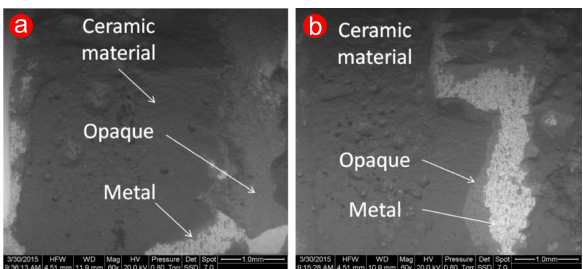
Figure 8: Metal remain areas on (a) drop form and (b) plate form